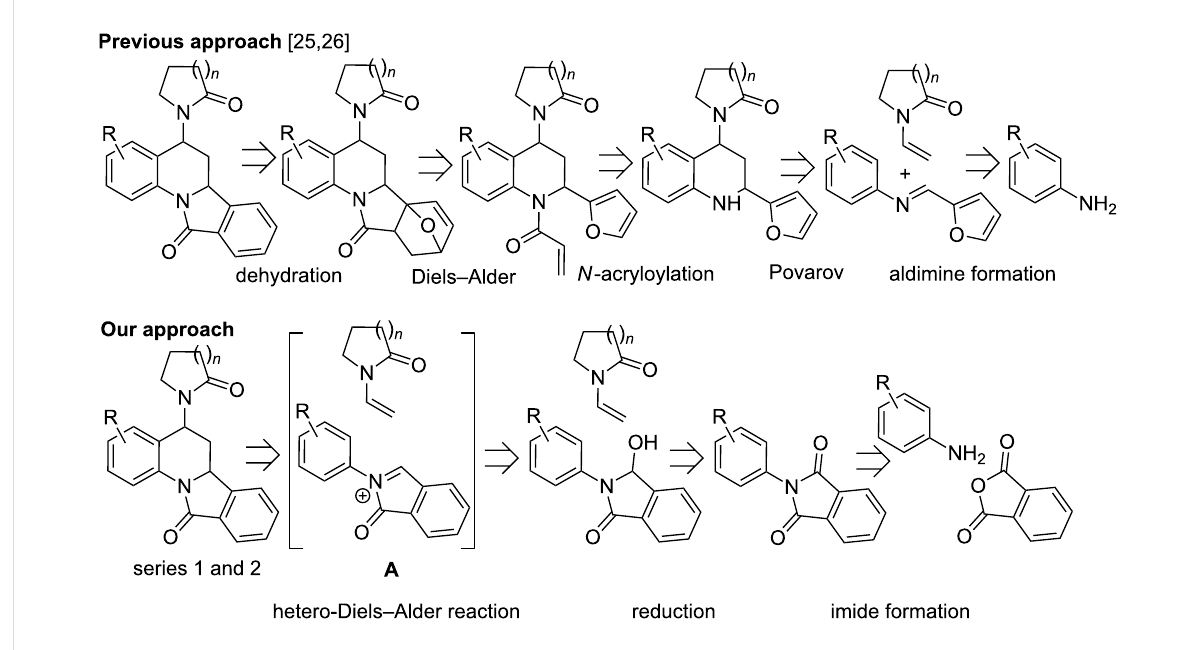
Scheme 1: Comparison of the retro-synthetic approach for the synthesis of isoindoloquinoline skeleton reported in the literature and our strategy.